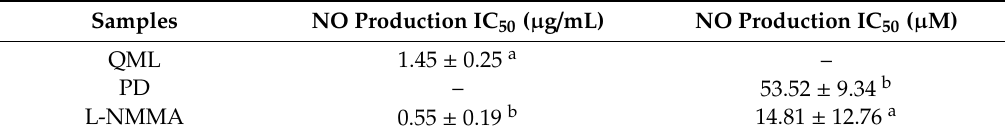
Table 1. IC 50 values of Quercus mongolica leaf extract (QML) and pedunculagin (PD) on inhibitory activity of nitric oxide (NO)